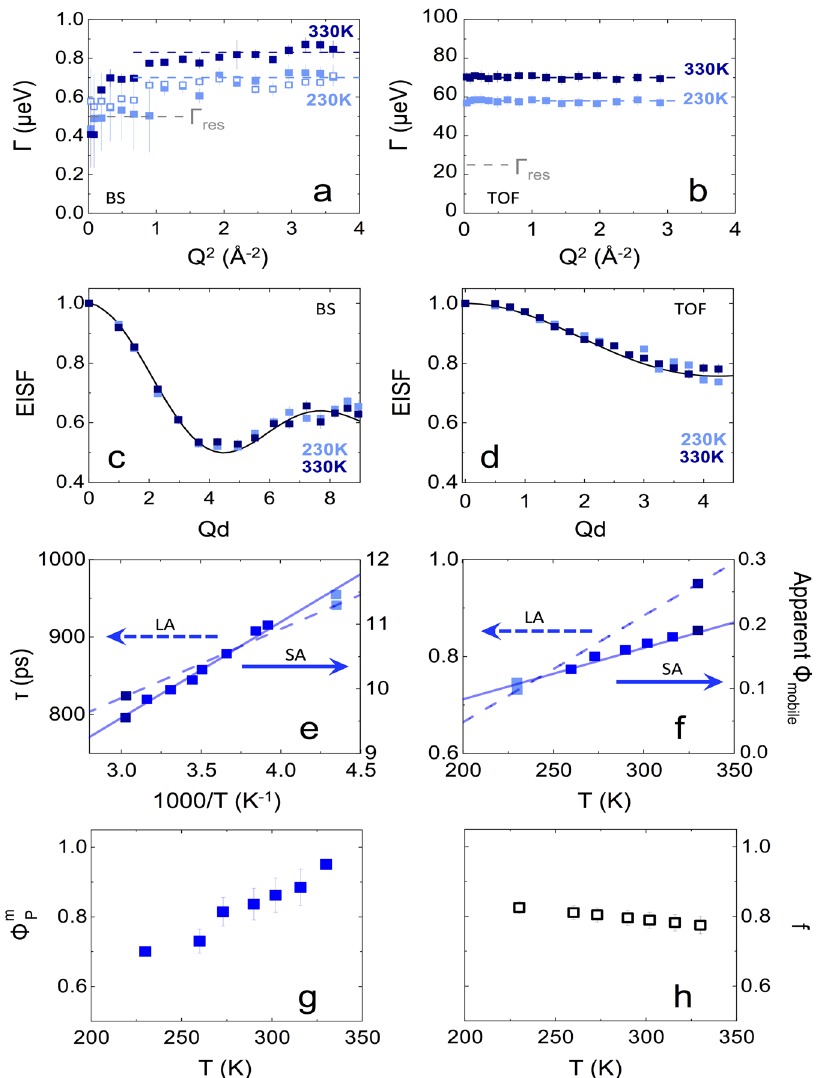
Fig. 3 Dry PA analysis of QENS data. a , b Linewidth HWHM ( Γ ) dependence on Q 2 measured for the dry polymer (at selected temperatures 230 and 330 K) by ( a ) BS with (half) resolution Γ res = 0.5 μ eV, shown in gray; data acquired within Δ E -range of ± 30 and ± 4.5 μ eV are shown with solid and open markers, respectively; b Γ ( Q 2 ) data obtained by TOF with Γ res = 22.5 μ eV. The error bars correspond to the fi tting uncertainties of the linewidth. c , d EISF as a function of Qd (Eq. (3)), accounting for the fraction of mobile protons in the dry PA shown in Fig. 2, obtained from BS and TOF data, respectively. The model fi t for an out-of-plane, two-state, fl ip of the MPD ring computed from Eq. (2) (detailed in Supplementary Note 4: Model 1) is shown as a black solid line. e , f The corresponding rotational relaxation times computed by τ 0 = ℏ / Γ P , and fraction of mobile protons (indicated in Fig. 2c), as a function of temperature, observed within BS ( ∼ ns) and TOF (~10 ps) timescales. g Mobile proton fraction ϕ m ; h Fraction undergoing both SA and LA motion ( f ). The P error bars correspond to the maximum range compatible with the data and model employed. Source data fi les